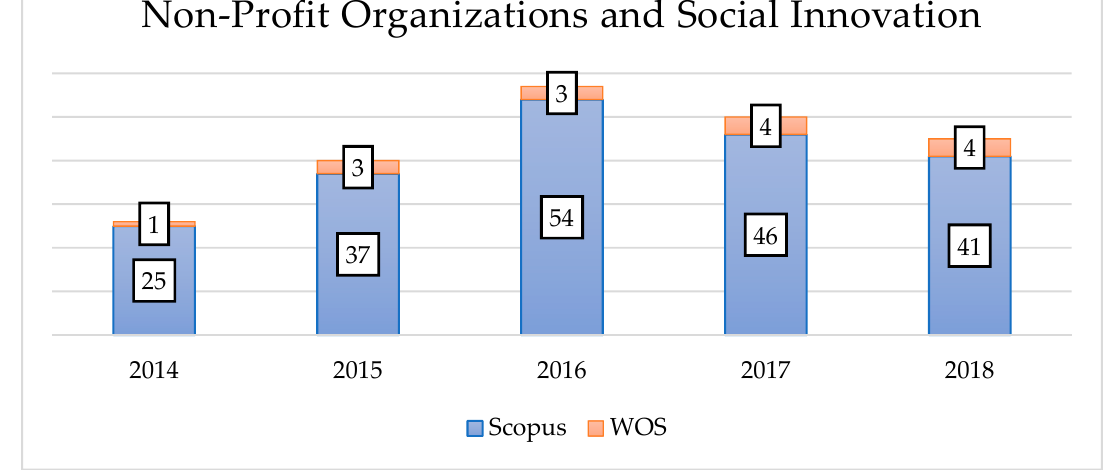
Figure 3. Documents related to non-profit organizations and social innovation (2014–2018). Source: Query on Scopus and Web of Science (WOS) (2019).